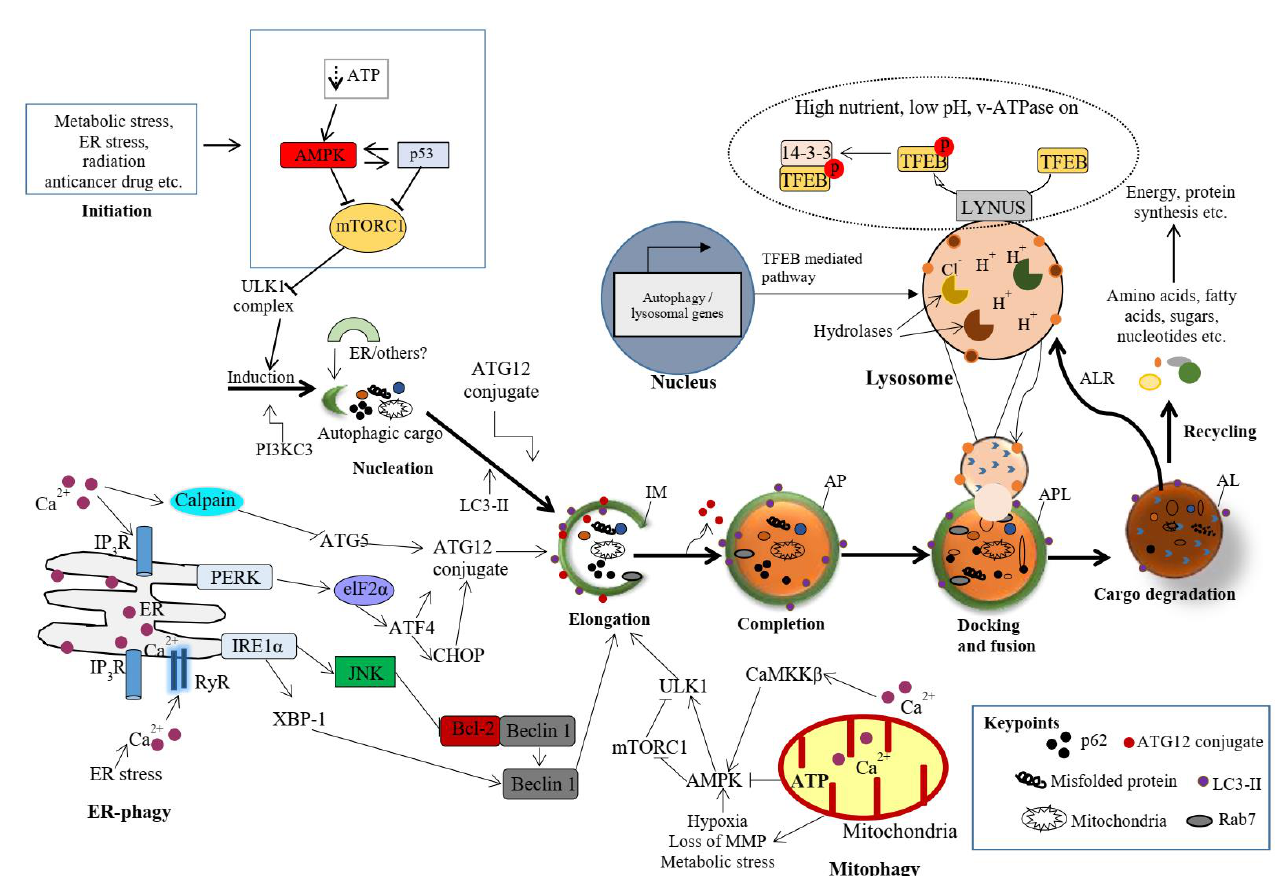
Figure 1. Molecular mechanisms of various stages of autophagy. Autophagy is activated in response to various cellular stresses and is triggered by a decrease in rapamycin complex 1 (mTORC1) activity due to the activation of AMP-activated protein kinase (AMPK) or p53 signaling. mTORC1 suppresses the activity of Unc-51-like autophagy activating kinase 1 (ULK1) complex. Therefore, inhibition of mTORC1 causes the initialization of the ULK1-mediated formation of the isolation (autophagosomal) membrane (IM) in association with the class III phosphatidylinositide 3-kinase (PI3K) complex (PI3KC3). The IM expands into an autophagosome (AP) with a double-layer membrane, which can engulf any cellular component, including proteins, damaged organelles and lipid droplets. The AP merges with the lysosome (via LAMP-1, 2), forming autophagolysosome (APL) or autolysosome (AL), and resulting in the degradation of the cargo by cathepsins and the autophagic lysosome reformation (ALR). The nucleation, elongation and maturation of the IM are dependent on two ubiquitin-like conjugation systems (ATG12 and ATG8), which involve multiple autophagy proteins, including Beclin1, ATG5, ATG16 and MT-associated protein 1 light chain 3 (LC3). The AL provides an acidic milieu for hydrolytic enzymes to digest the engulfed components. Nuclear localization of transcription factor EB (TFEB) is critical to the formation of lysosomes and to the enhanced expression of autophagy proteins. Importantly, autophagy could be selective of mitochondria (mitophagy) or ER (ER-phagy) [7]. However, the detailed mechanisms of this selected autophagy are beyond the scope of this study.